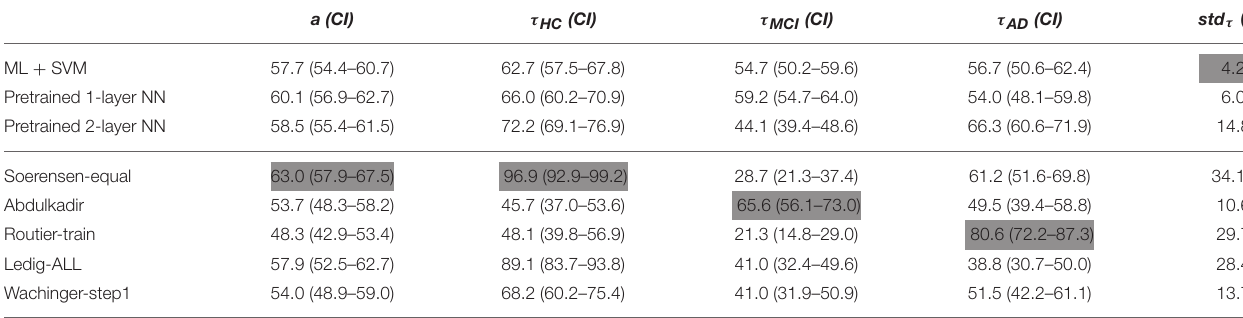
TABLE 5 | Accuracy performance measures for the multi-class scenario following the validation scheme in Bron et al. (2015).